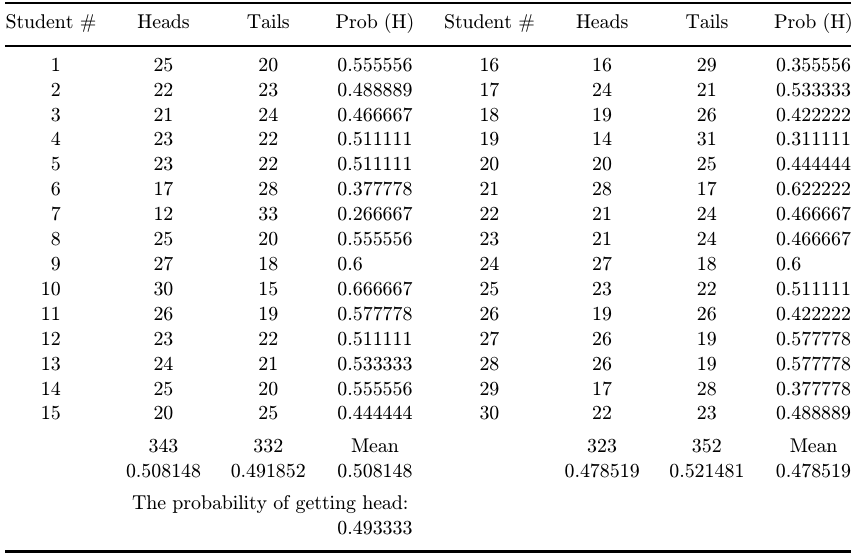
Table 1. Results for a group of 30 students, each °ipping a coin 45